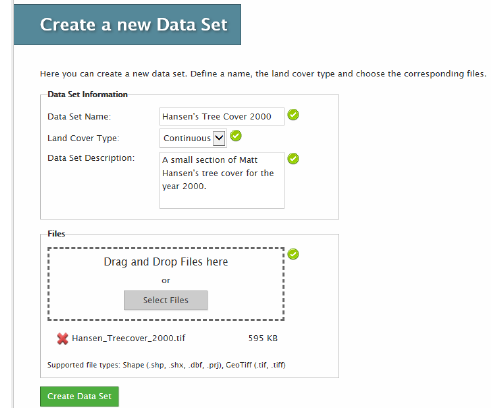
Figure 4. Uploading a data set to the system for